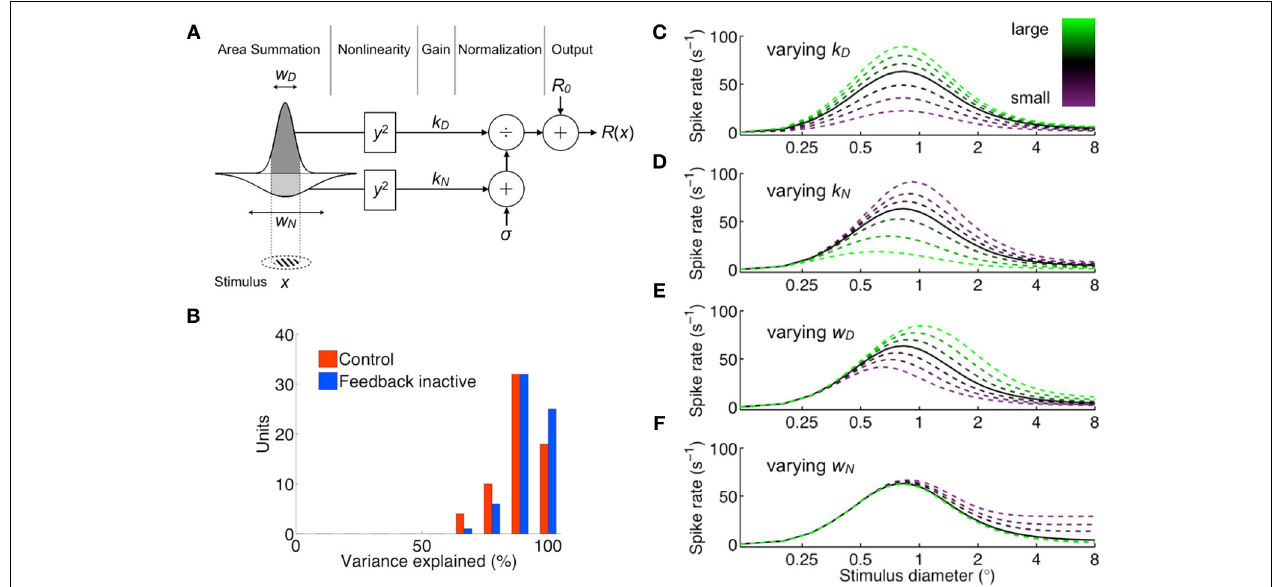
FIGURE 2 | Normalization area summation model (ratio of Gaussians). (A) Schematic representation of the model. The receptive-field-centered grating stimulus of diameter x determines the integration bounds of the excitatory drive (dark shading) and normalization pool (light shading) area summation components, characterized by spatial parameters w D and w N , respectively. Their outputs are squared and amplified by gains k D and k N before normalization. The constant σ represents baseline normalization pool activity and is set to unity without loss of generality. R 0 is the